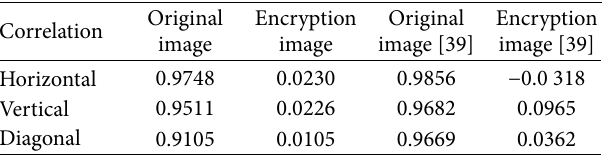
Figure 15: The decrypted image with its histograms (reproduced from Jing Luo et al. (2019), (under the Creative Commons Attribution License/public domain)). Table 3: Correlation coefficient